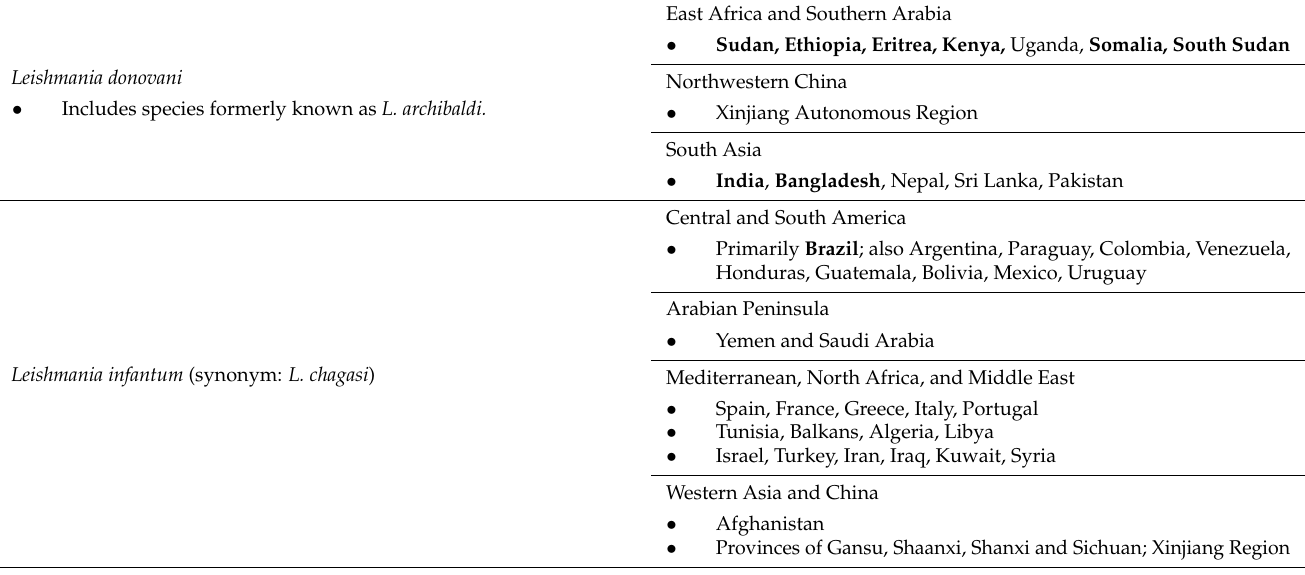
Table 2. Leishmania Species Causing VL and Their Geographic Distribution * ±